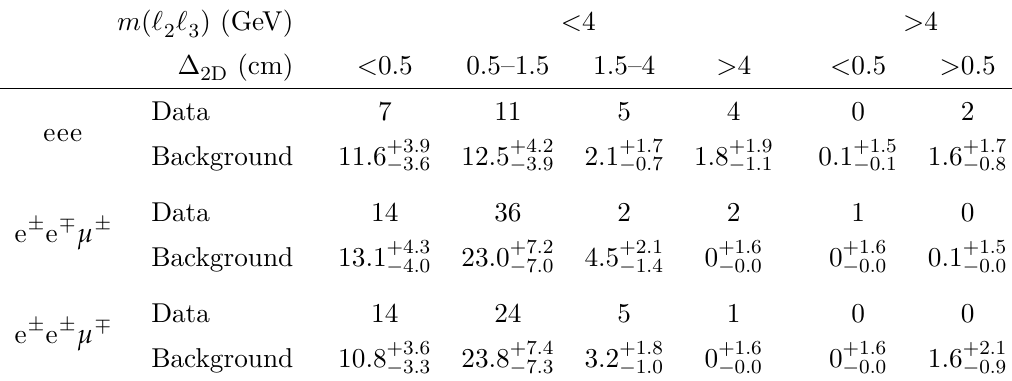
= 2 GeV and | V | 2 = N N ‘ = 12 GeV and | V | 2 = N N ‘